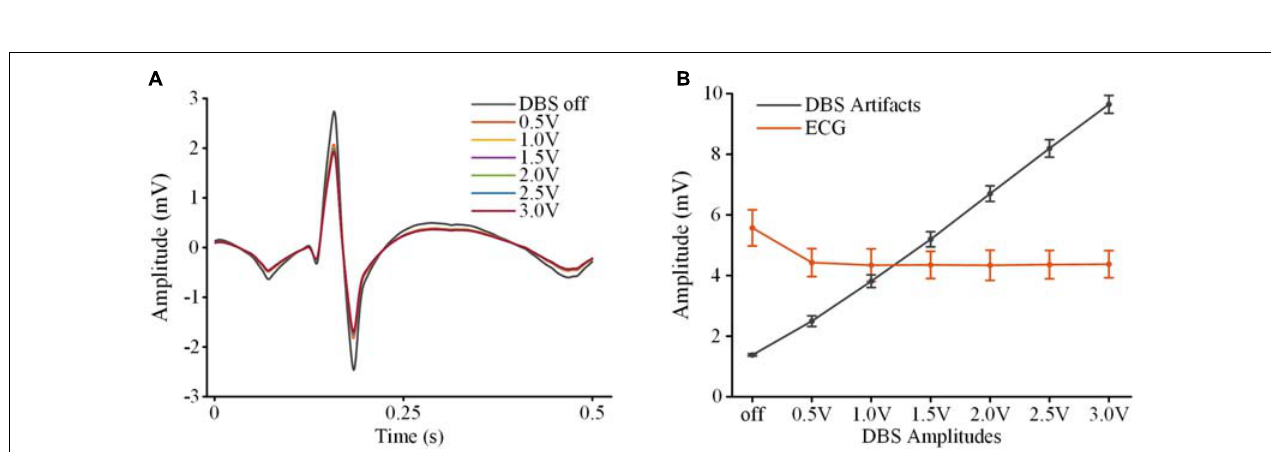
FIGURE 5 | Extraction of ECG spikes from monopolar recordings. (A) The averaged ECG spikes in DBS off and DBS on states. (B) The peak-to-peak values of the ECG spikes and DBS artifacts. The dots are mean values and the error bars are standard deviations.